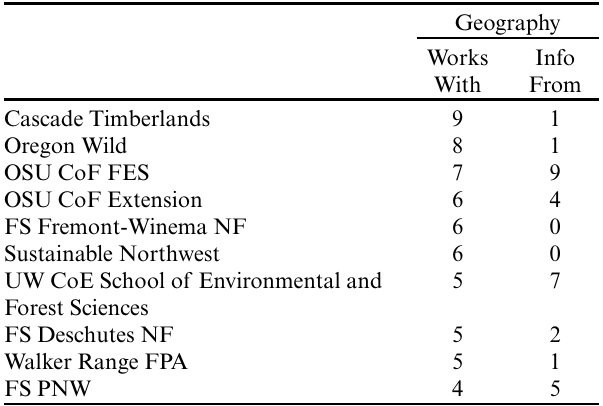
Table 5 . Top 10 organizations ranked by number of ties to working partners and information sources that focus on other geographic